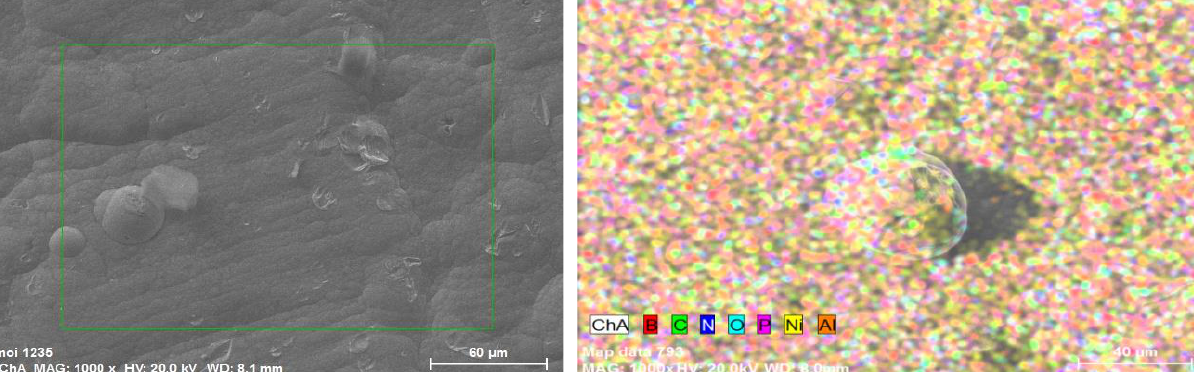
Figure 2. EDS analysis of the marked area on surface of as-deposited electroless Ni coating with embedded c-BN nanoparticles (Ni-BN).